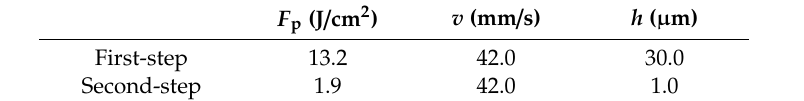
Table 2. Laser parameters applied for fabricating the microgroove textures shown in Figure 16.